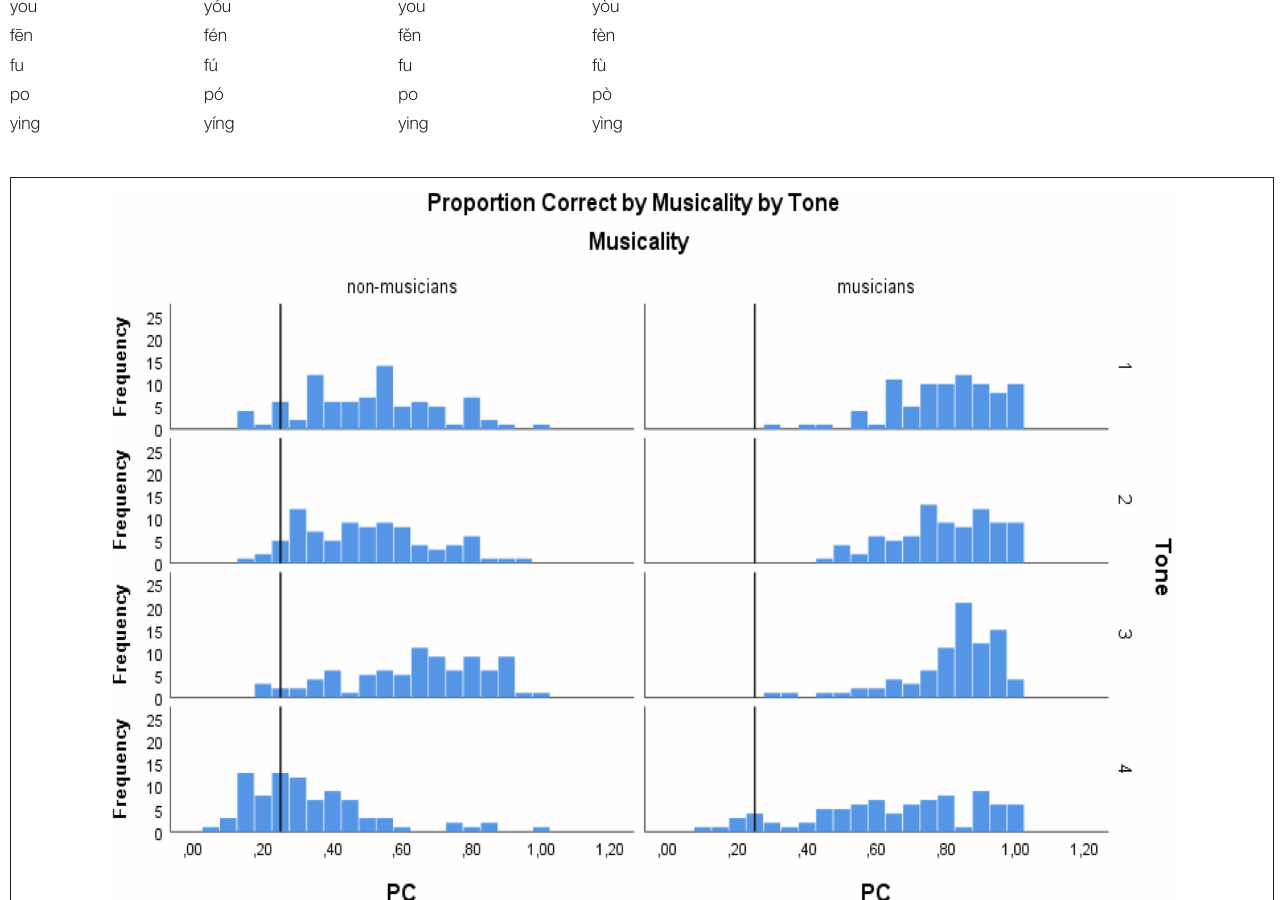
FIGURE A1 | A histogram of each participant’s accuracy on individual tone level. PC, Proportion Correct. The chance level of the accuracy is 0.25.